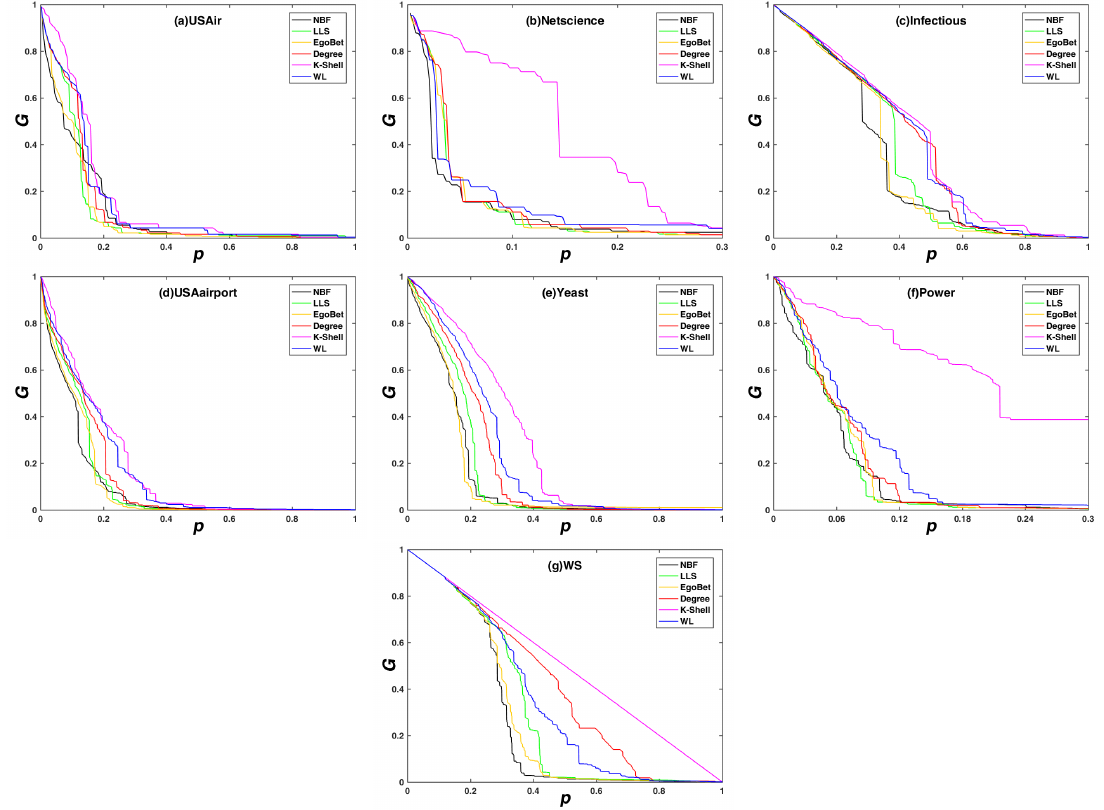
Figure 2. The network maximum connectivity coefficient ( G ) subjects with different dynamic attack strategies. Maximum connectivity coefficient ( G ) on the y -axis against the rate of removed node ( p ) on the x -axis. ( a ) the USAir network; ( b ) the Netscience network; ( c ) the Infectious network; ( d ) the USAirport network; ( e ) the Yeast network; ( f ) the Power network; and ( g ) the synthetic network